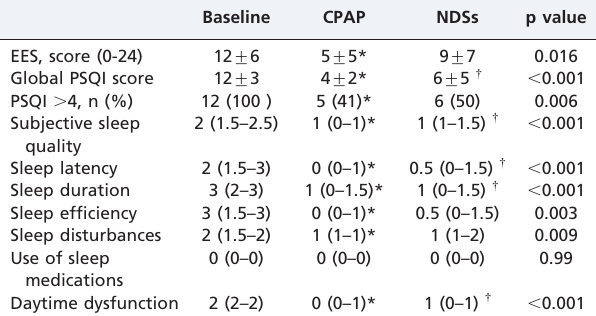
Nasal dilator strips as a placebo for sleep apnea Amaro ACS et Table 3 - PSQI component scores and global score of the participants baseline, nasal dilator strips and CPAP.